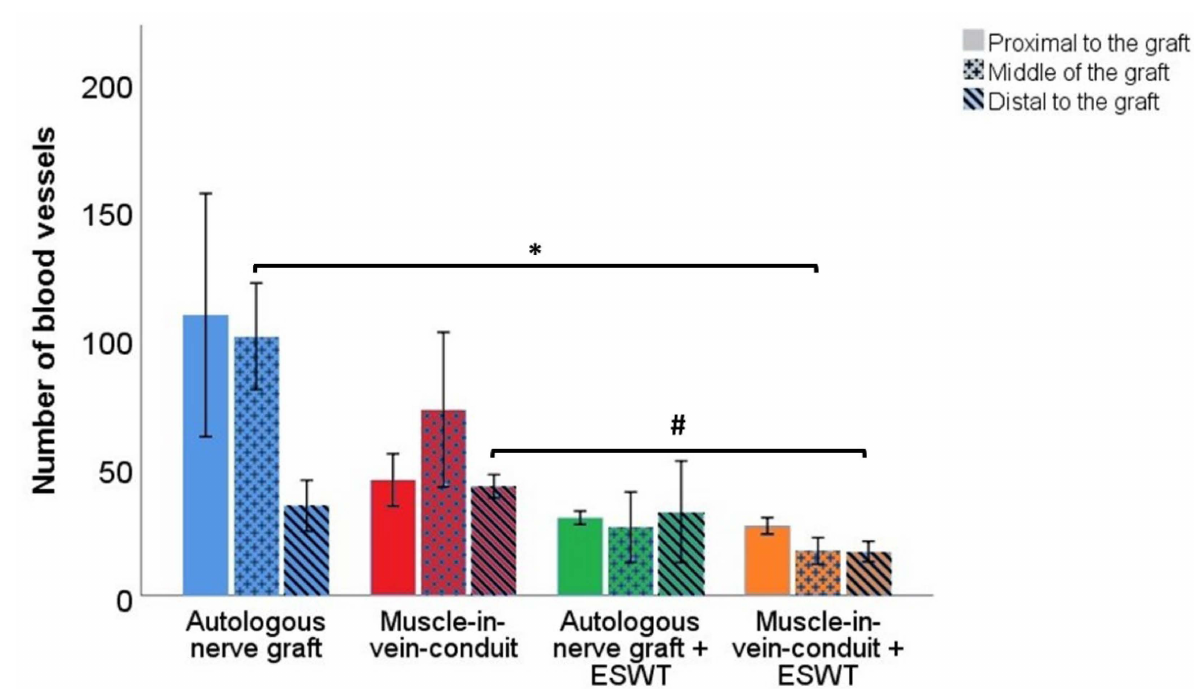
Figure 10. Number of blood vessels in different segments of the reconstructed right median nerve 12 weeks following resection of a 7 mm segment of the right median nerve and immediate recon- struction with an autologous nerve graft ( n = 4), a muscle-in-vein conduit ( n = 5), an autologous nerve graft + ESWT (autologous nerve graft with postoperative extracorporeal shockwave therapy) ( n = 3) or a muscle-in-vein conduit + ESWT (muscle-in-vein conduit with postoperative extracorporeal shockwave therapy) ( n = 5). Statistical evaluation was performed with the nonparametric Kruskal– Wallis test and the Dunn–Bonferroni post hoc test. For subgroup analysis of identical reconstructive approaches, the Mann–Whitney U test was used. Repeated measurements of the same group were compared by means of the nonparametric Friedman test. Note: * p < 0.05, # p < 0.05 in subgroup analysis